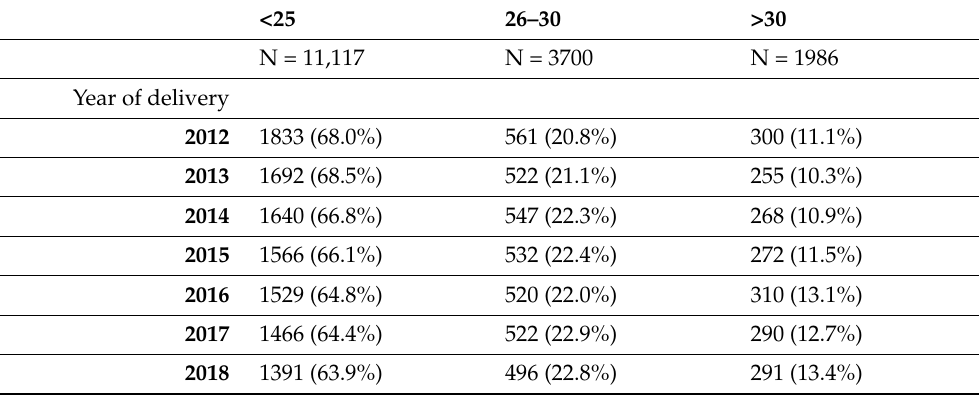
Table 2. Distribution of body mass index (BMI) in pregnant women.